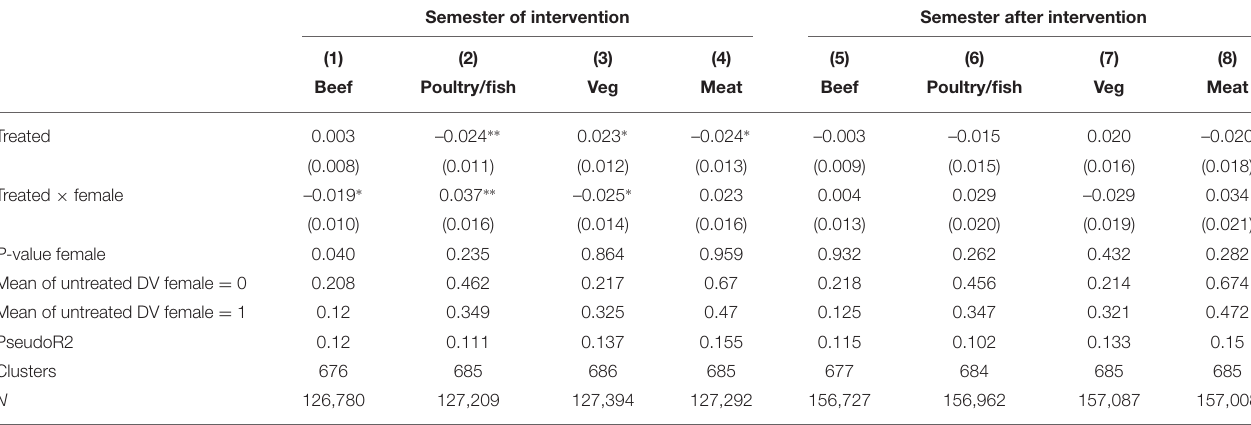
TABLE 2 | Effect of pamphlets by